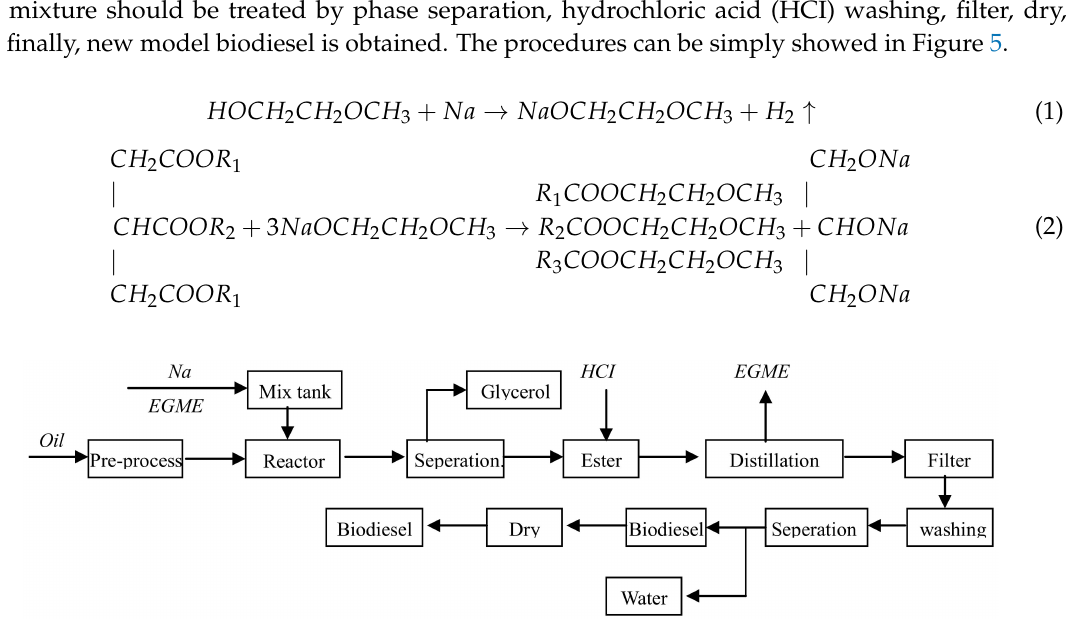
Figure 5. Biodiesel producing